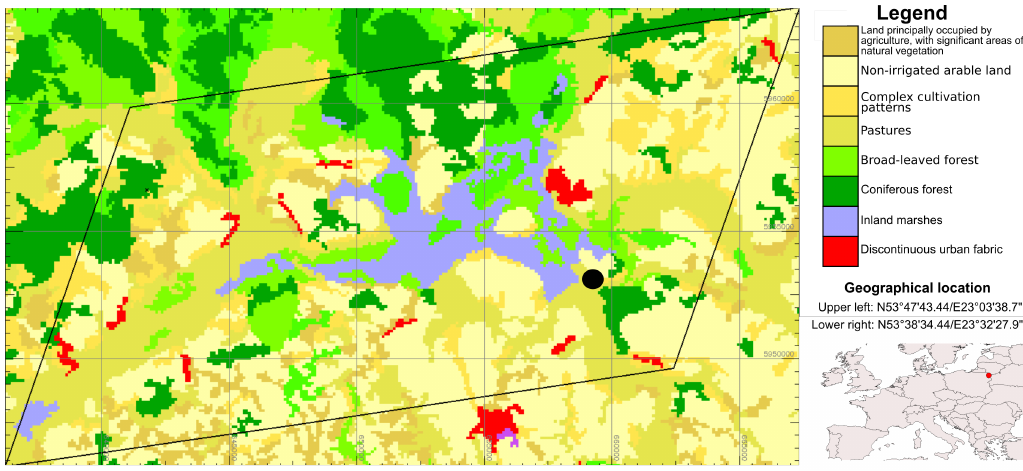
Figure 3. Land cover (according to the CORINE land cover map) and location of the study area in the upper Biebrza basin, Poland. The black dot represents the location of the flux tower in